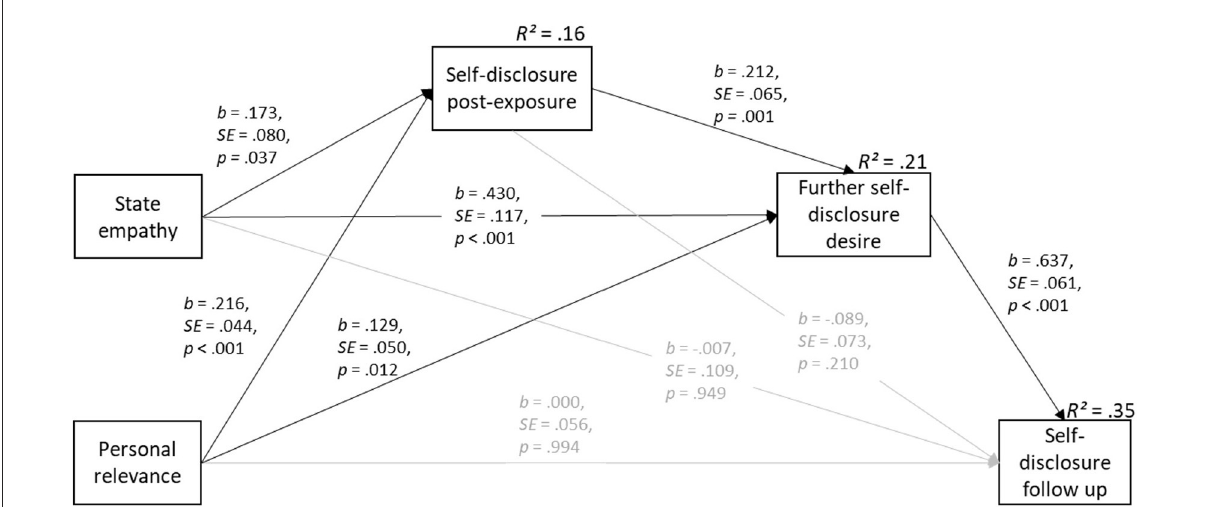
FIGURE3 Effects of state empathy and personal relevance on self-disclosure follow up (Model 1). N = 328, unstandardized regression coefficients, 5.000 bias-corrected bootstrap samples. Model fit: χ 2 = 6.57, df = 8, p = 0.584; CFI = 1.00; RMSEA = 0.000, 90% CI [0.000, 0.057]; SRMR = 0.022. Covariates: Gender, age, music, shot scale (for all three DVs).